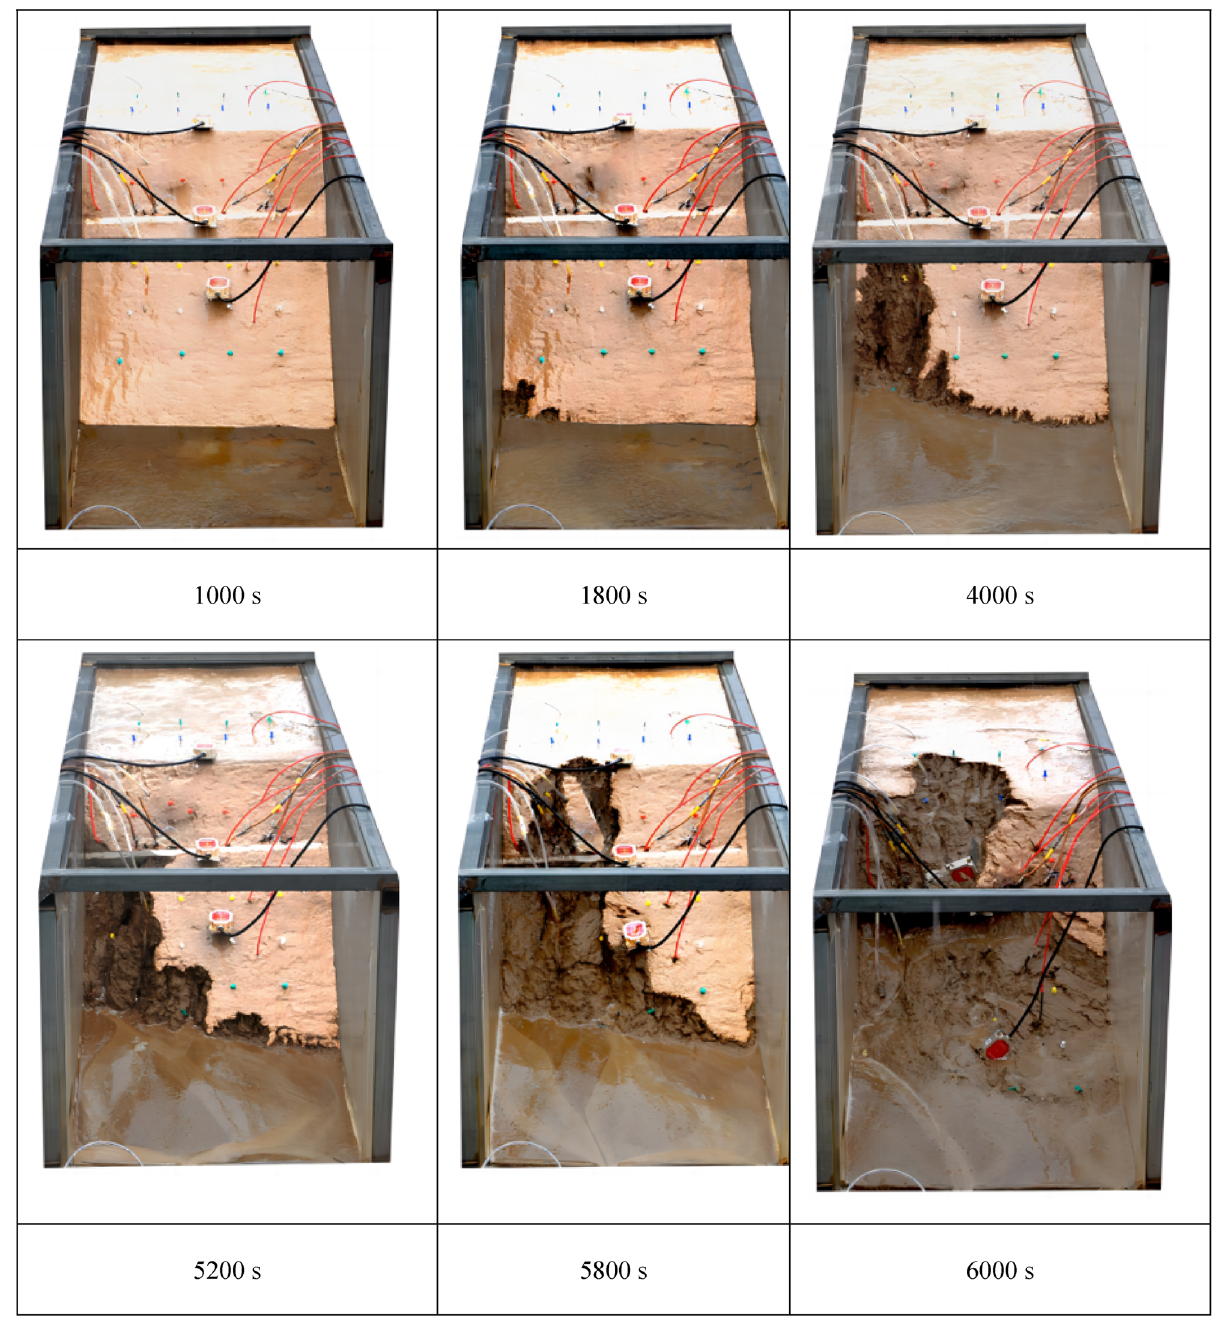
Figure 4. Evolution of landslide with retaining-wall locked